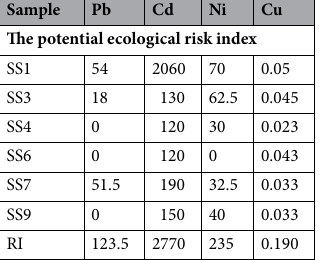
Table 8. Ecological risk index (RI) of the study